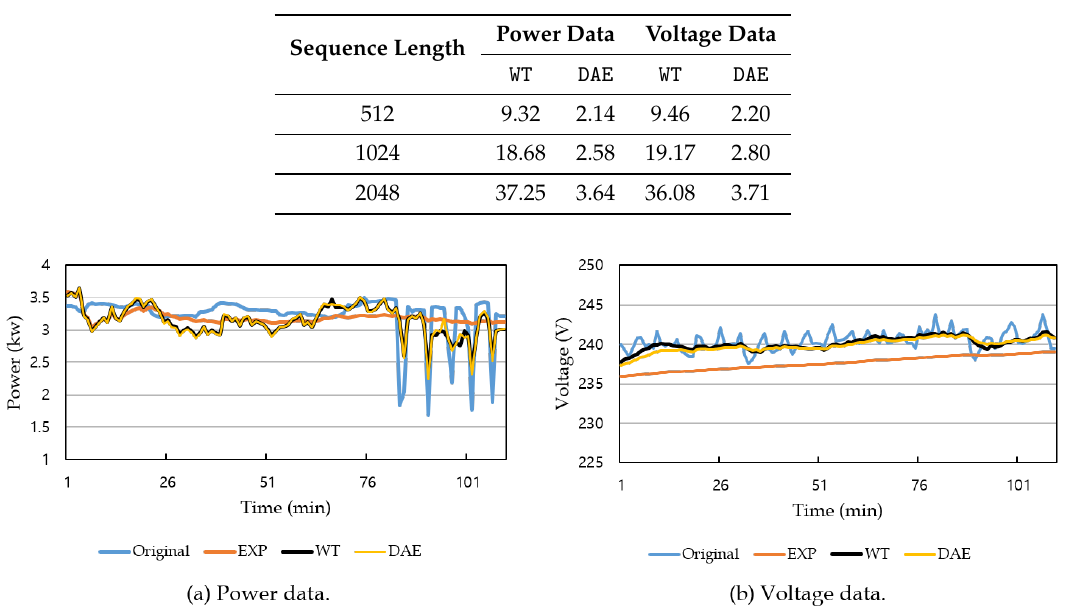
Table 4. Average computation time (ms) for the measurement noise variance estimation.